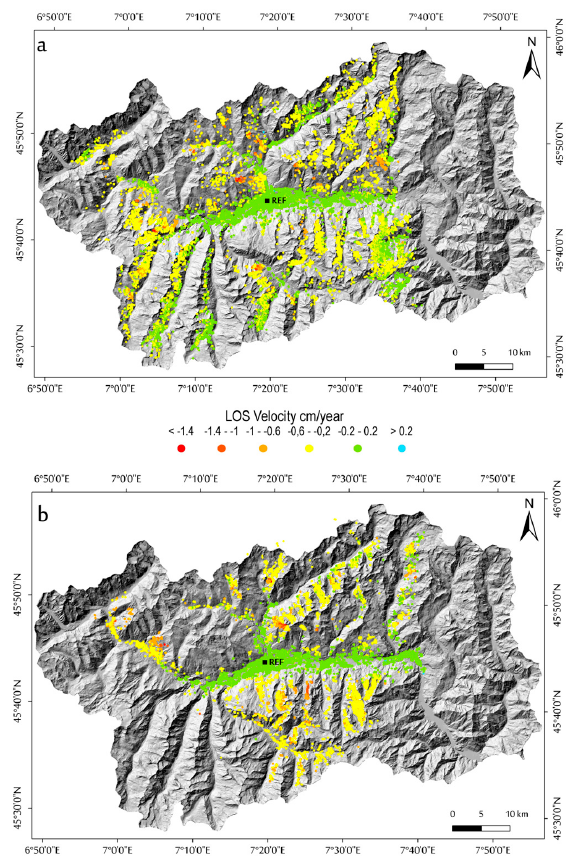
Figure 6. Surface velocities measured along the satellite LOS for the Envisat dataset: ( a ) in ascending orbit for the time period from June 2004 to October 2010 and ( b ) in descending orbit for the time period from September 2004 to October 2010. The light blue polygons correspond to the present glaciers.